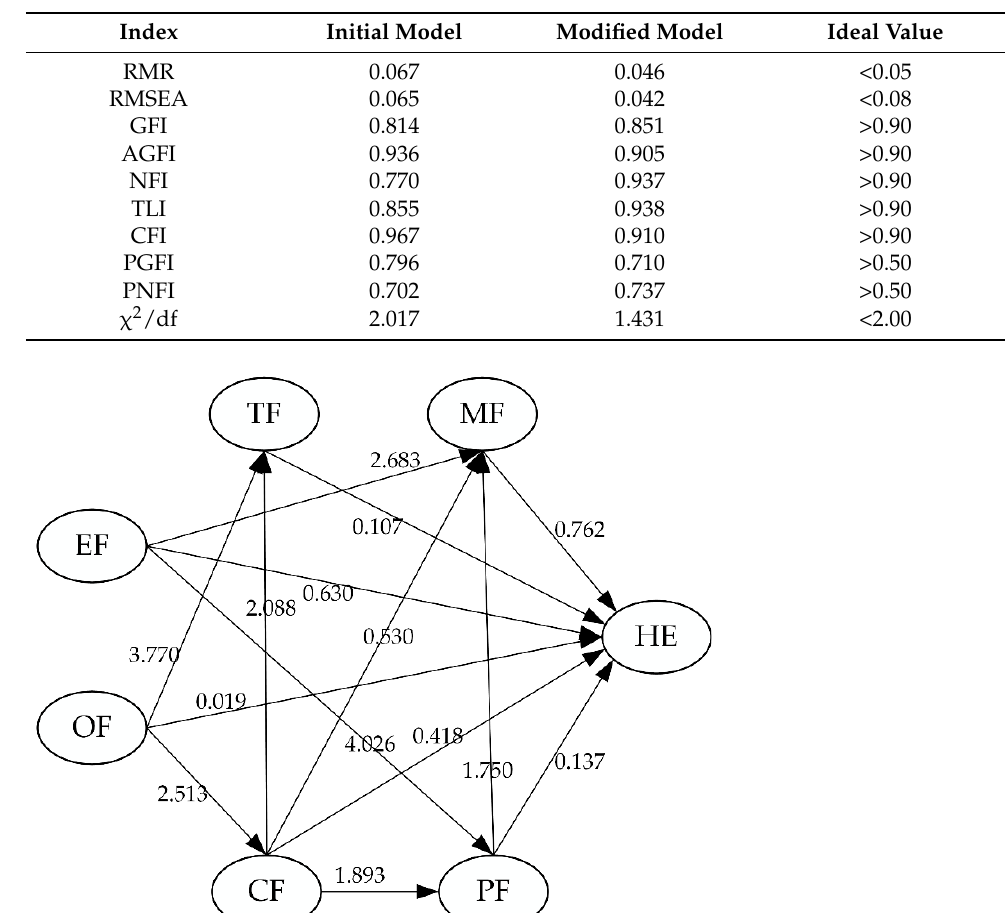
Table 6. The adaptation degree results of the optimal model.